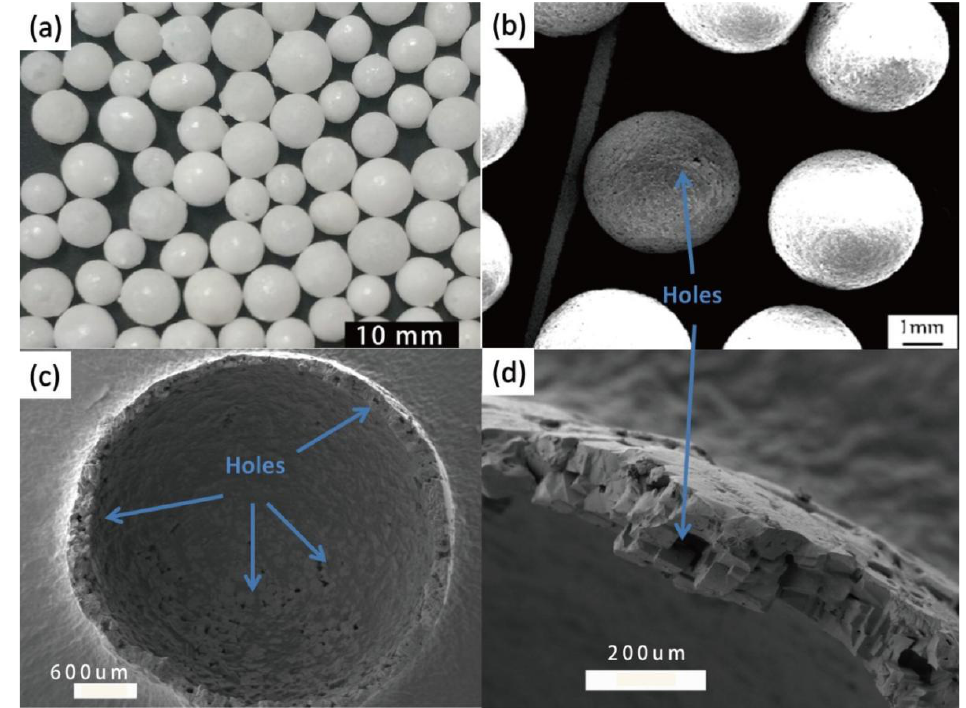
Figure 2. Macro photograph ( a ) and SEM images ( b – d ) of Al 2 O 3 hollow spheres.